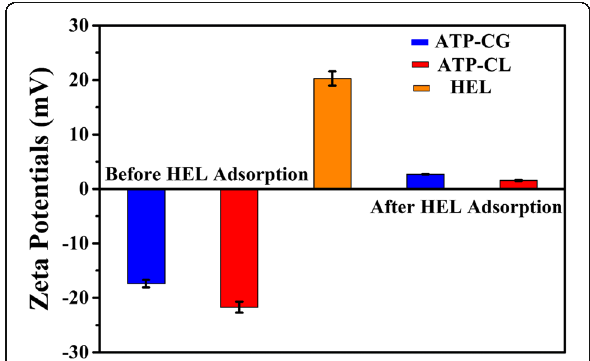
Fig. 10 Zeta potentials of HEL and microspheres before and after HEL